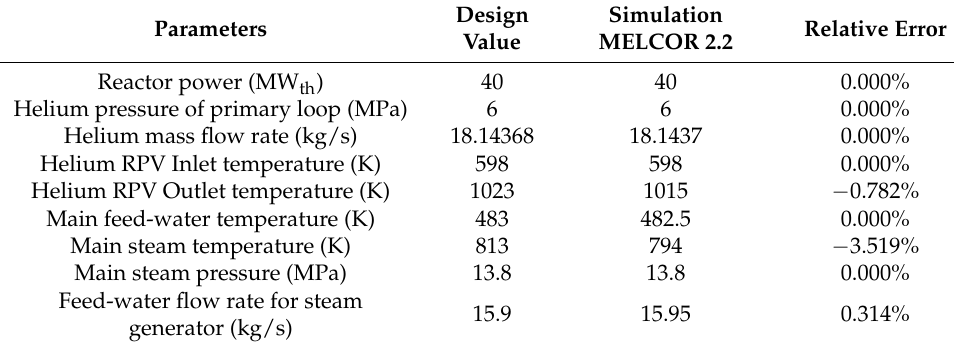
Table 7. MELCOR 2.2 code model qualification table at “steady-state” level.